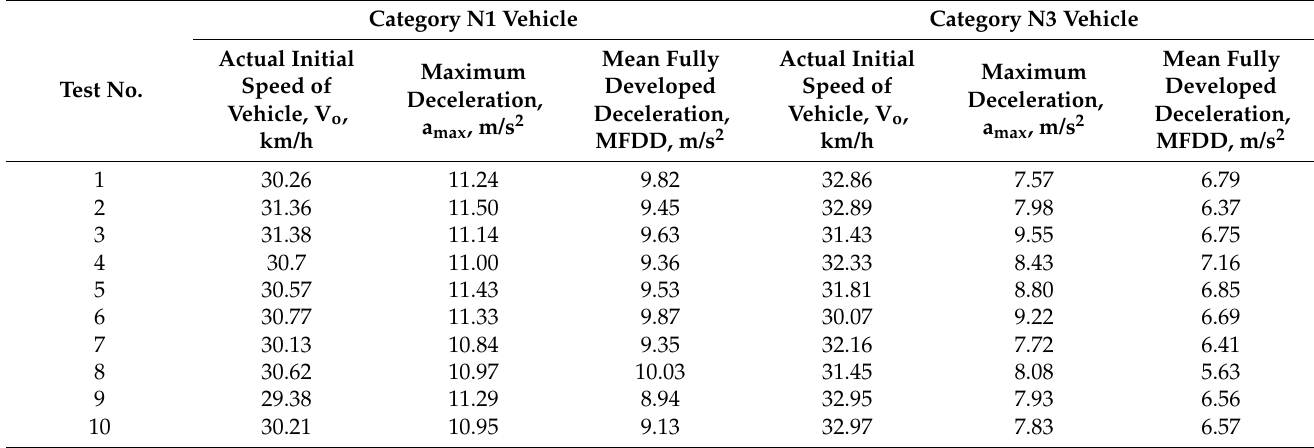
Table 5. Parameters of the braking process on a dry concrete pavement from 30 km/h.